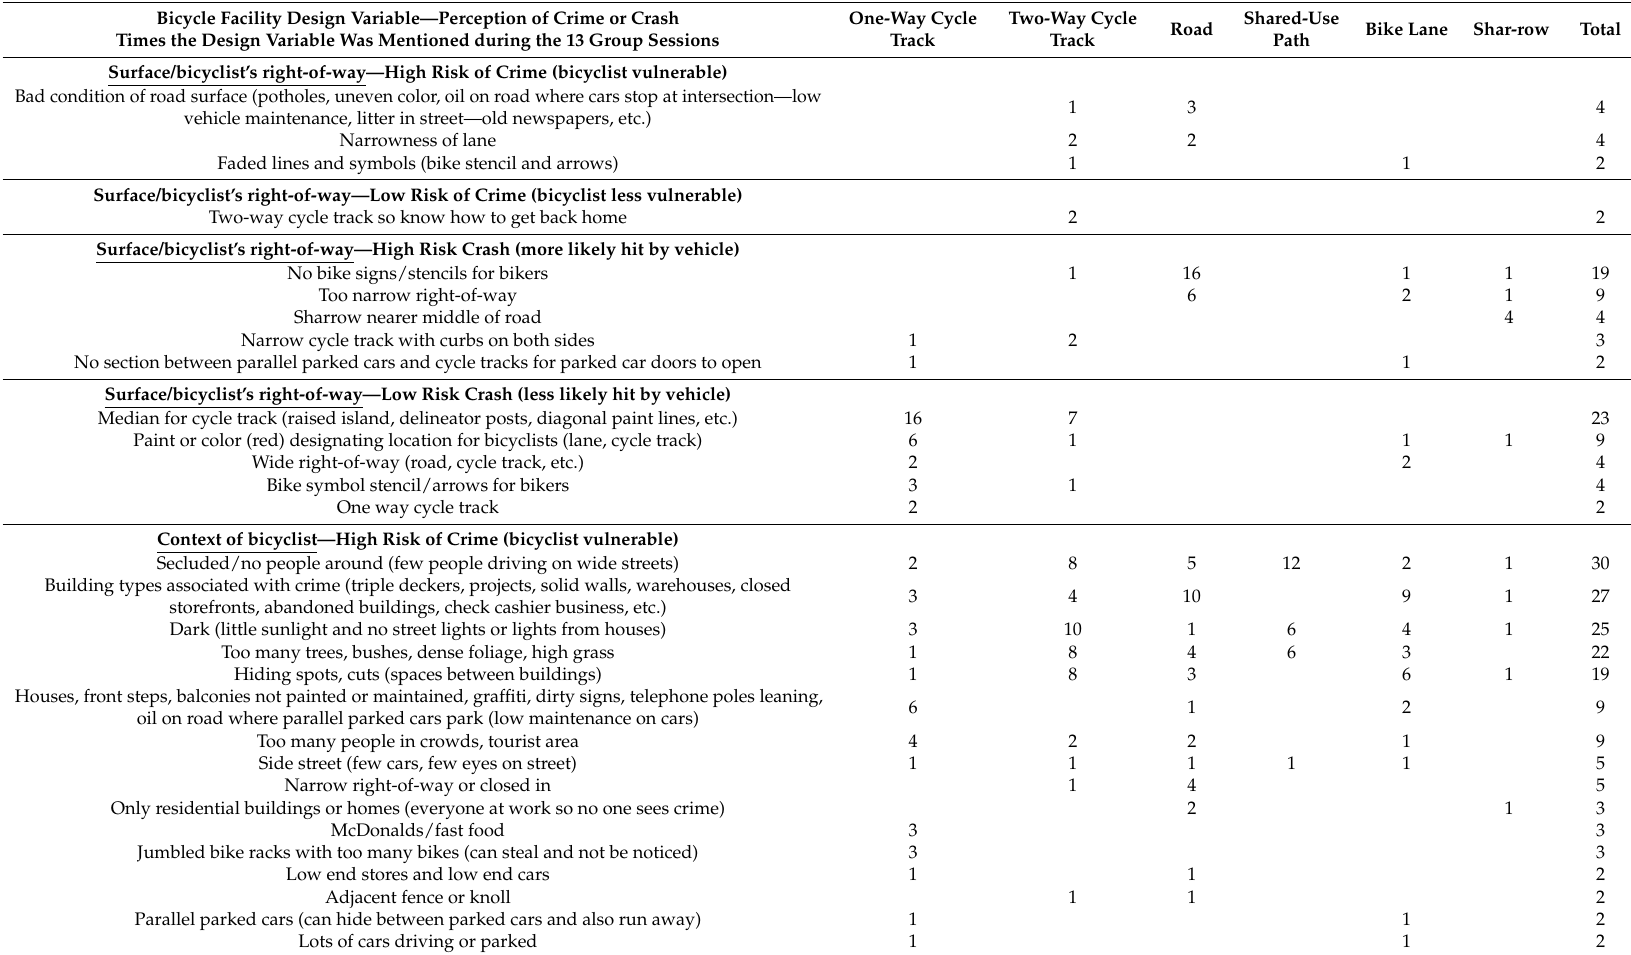
Table 5. Surface and Context Design Variables Related to Crime or Crime